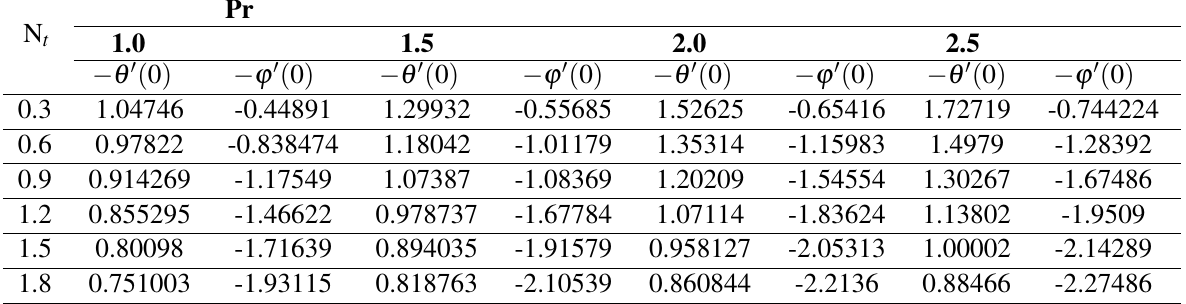
Table 3 Values of − θ (cid:48) ( 0 ) and − ϕ (cid:48) ( 0 ) for different values of thermophoresis parameter N t and Prandtl number Pr with n